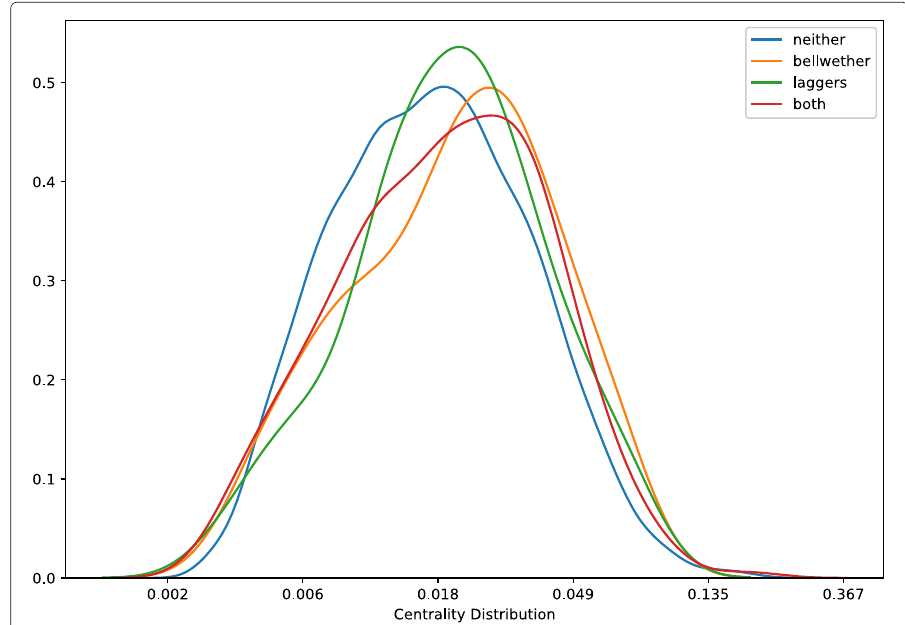
Fig. 5 The distribution of PageRank centrality values grouped by whether a node is a bellwether, whether it lags the discussion, whether it neither leads nor lags the discussion or whether it both leads and lags the discussion